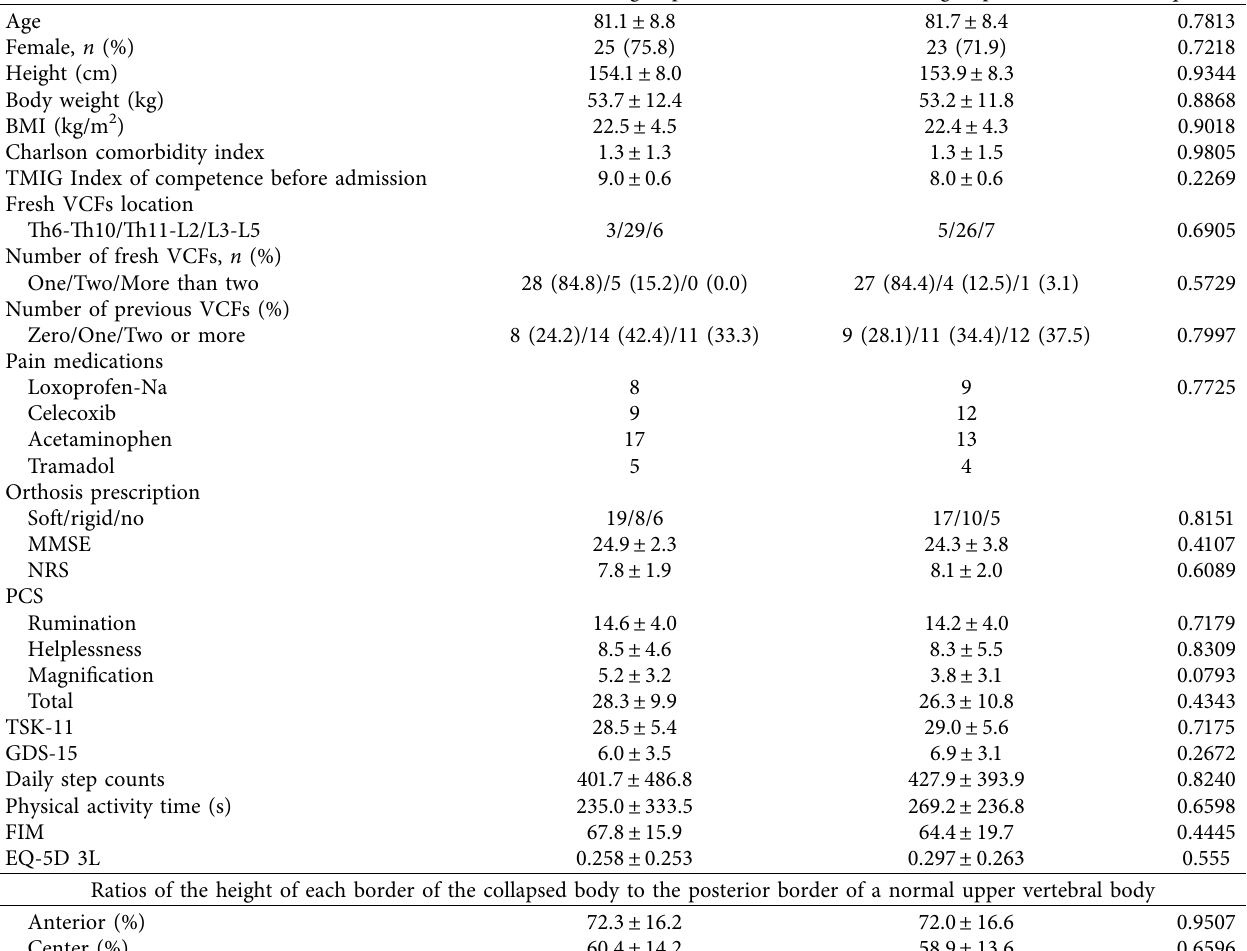
Table 2: Participants’ characteristics and outcome measures at